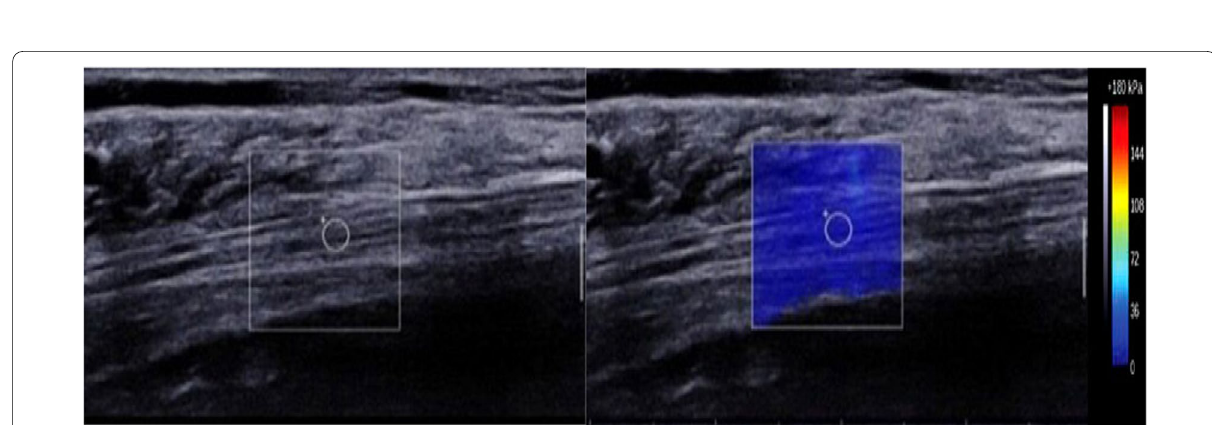
10.2 mm 2 ). (Right) shear-wave elastography displayed = 35.7 kPa =